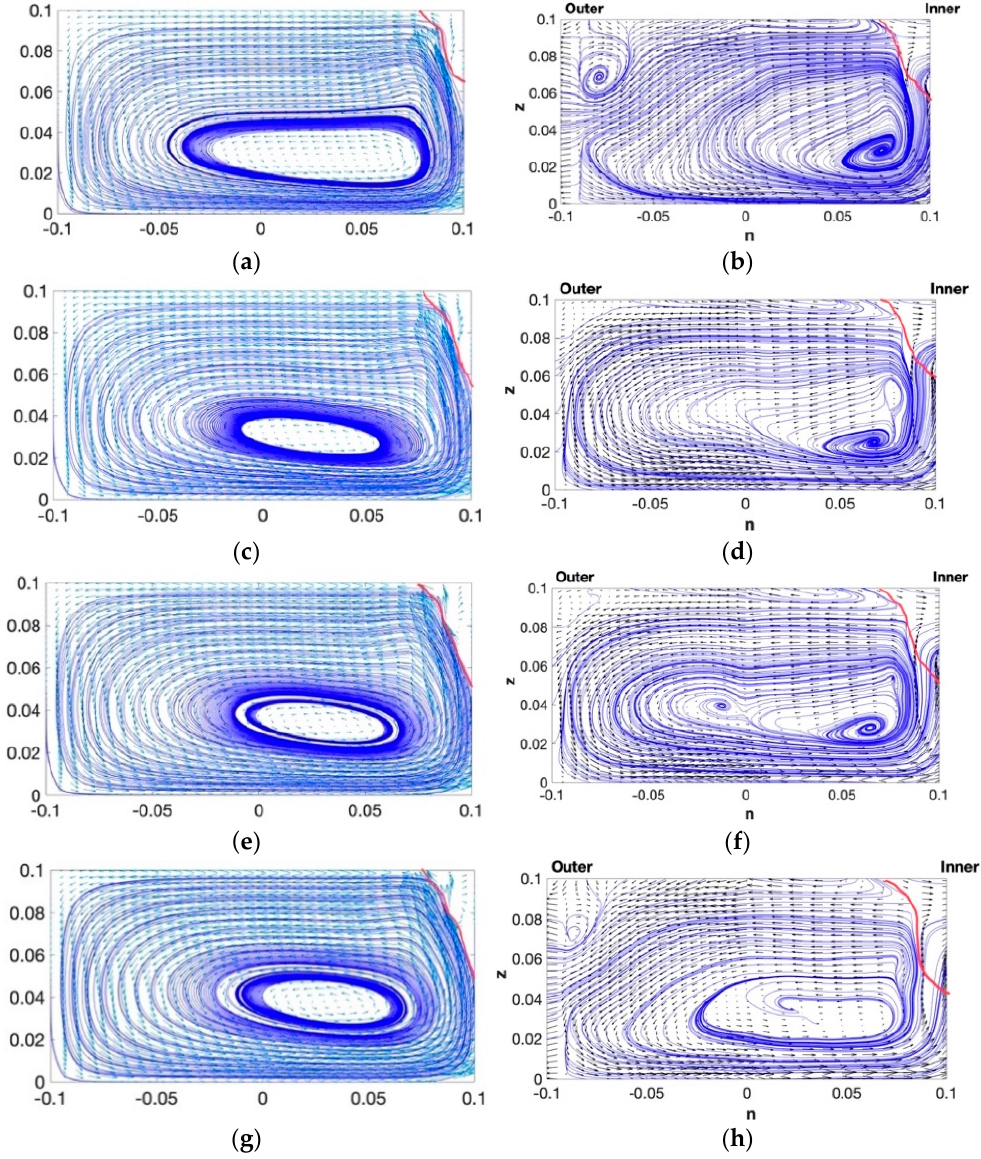
Figure 6. Secondary flows at the 90 degree section under different conditions: ( a , b )—No jet; ( c , d )—S = 3.5; ( e , f )—S = 10; ( g , h )—S = 16.5. The left column figures represent the numerical results, and the right column are the experimental